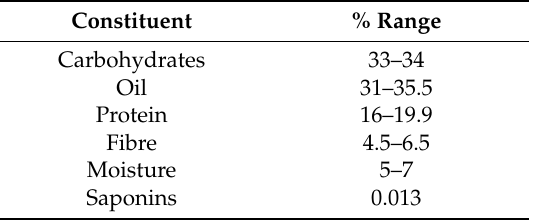
Table 1. Composition of N. sativa seeds according to Mollazadeh et al.